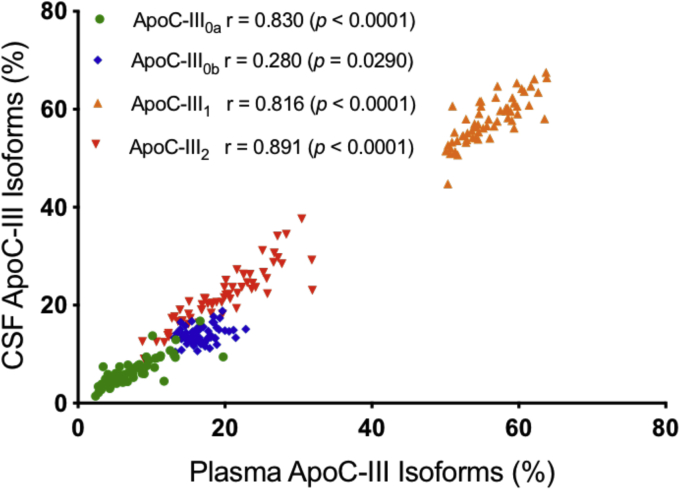
Correlation between apoC-III isoforms in the paired plasma and CSF samples. Shown are the parametric Pearson's correlation coefficients for apoC-III0b, apoC-III2, and the nonparametric Spearman correlation coefficients for apoC-III0a and apoC-III1.